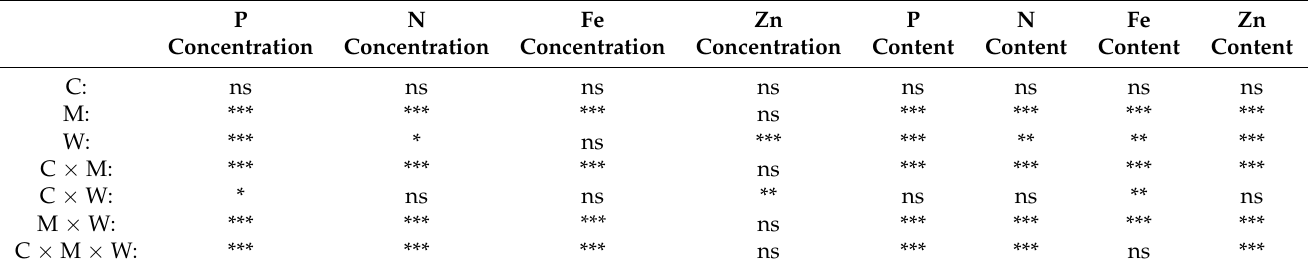
Table 4. Significant differences in cultivar (C), AM inoculation (M) and substrate water content (W) and their interactions are indicated with asterisks (Kruskal-Wallis test, n = 4, p < 0.05 (*), p < 0.01 (**), p < 0.001 (***) and p > 0.05